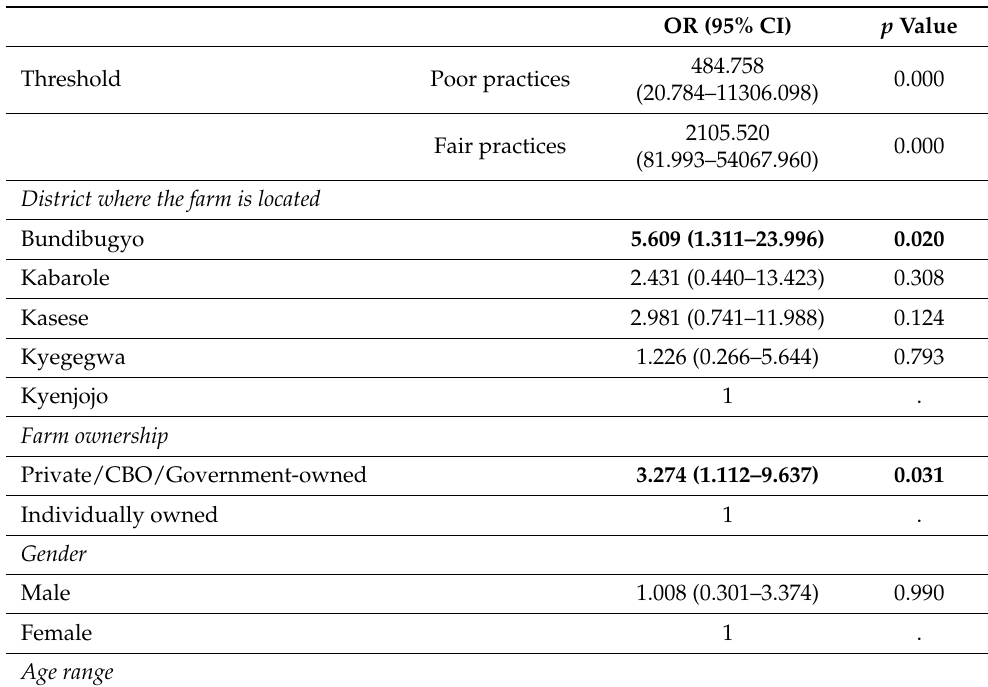
Table 8. Ordinal logistic regression analysis of factors associated with practices of water quality management among fish farmers of the Rwenzori